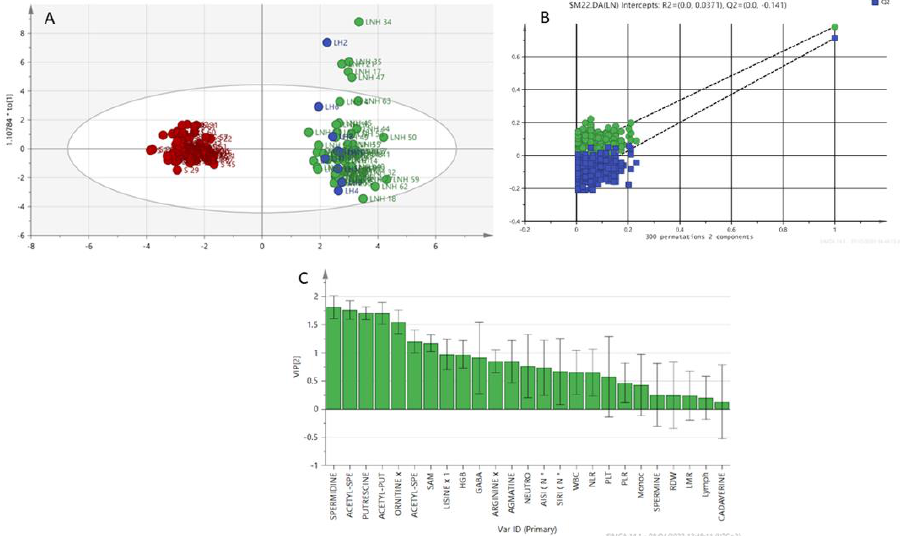
Figure 4. ( A ) OPLS-DA, NHL patients (green), LH patients (blue) and healthy patients (red). ( B ) Variable importance in projection (VIP) plot: important features identified by OPLS-DA in descending order of importance. The graph represents the relative contribution of parameters to the variance between individuals. High value of VIP score indicates great contribution to the group separation (LNH+LH vs. healthy). ( C ) Permutation (LNH+LH vs. healthy).